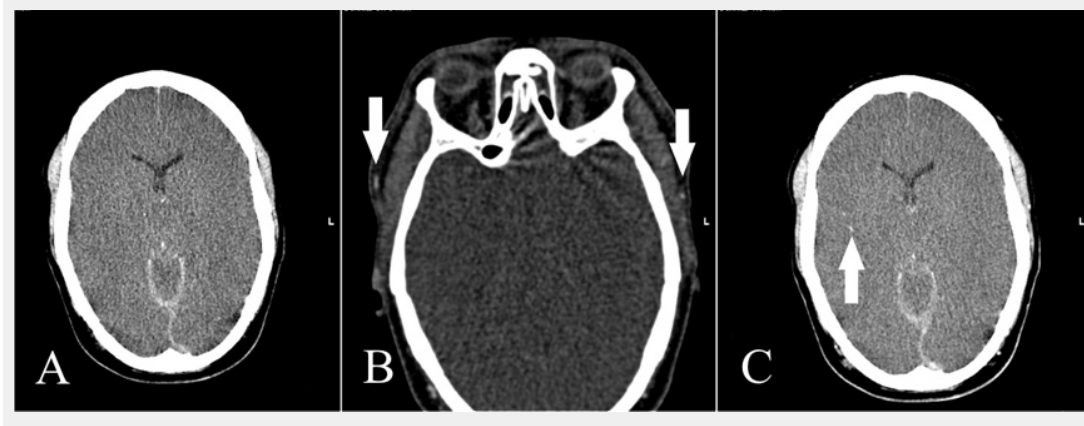
Figure 2 A: Non-contrast CT shows subarachnoid and subdural haemorrhage; gray matter/white matter differentiation is not discernible. B: CTA with contrast media in the superficial temporal artery on both sides indicating a technically sufficient study (white arrows). There is no intracranial arterial opacification. C: Venous-phase CT shows opacification of an M3 segmental artery on the right (white arrow) but no contrast in the M4 segments of the middle cerebral artery and/or the internal cerebral veins. Cerebral circulatory arrest was confirmed.